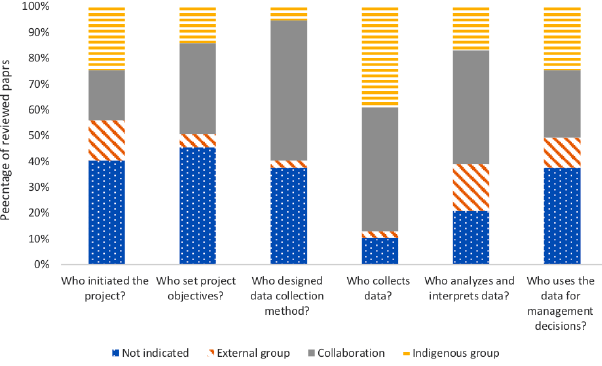
Fig. 3 . Percentage of initiatives reviewed ( n = 77) that indicated which groups participated in monitoring activities.